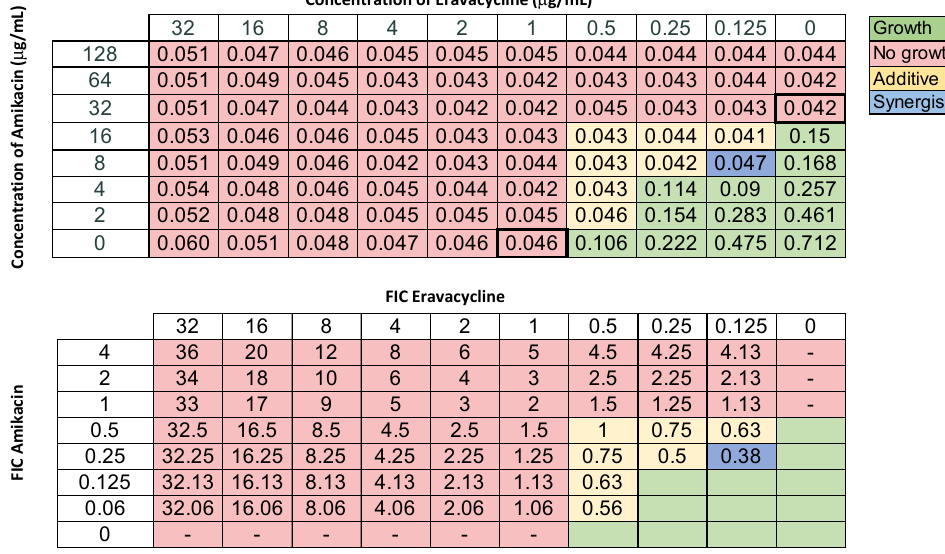
Figure 1. Representative checkerboard assay with eravacycline and amikacin. The XDR strain ACB9 was grown in the presence of varying concentrations of amikacin and eravacycline. Top: OD 600 measurements following 16 h of static growth at 37 °C. The MICs for each drug alone are outlined with a bold box. The pink boxes indicate wells with no growth (<0.08) and green-colored boxes indicate bacterial growth. The box in the bottom right corner contains no drug and serves as a growth control. Bottom: Fractional inhibitory concentrations (FICs) were calculated for each drug (concentration/MIC) and added together for all wells where no growth was observed. Yellow-shaded boxes indicate additive interactions (FICI between 0.5 and 1.0) and blue boxes indicate synergistic interactions (FICI < 0.5).